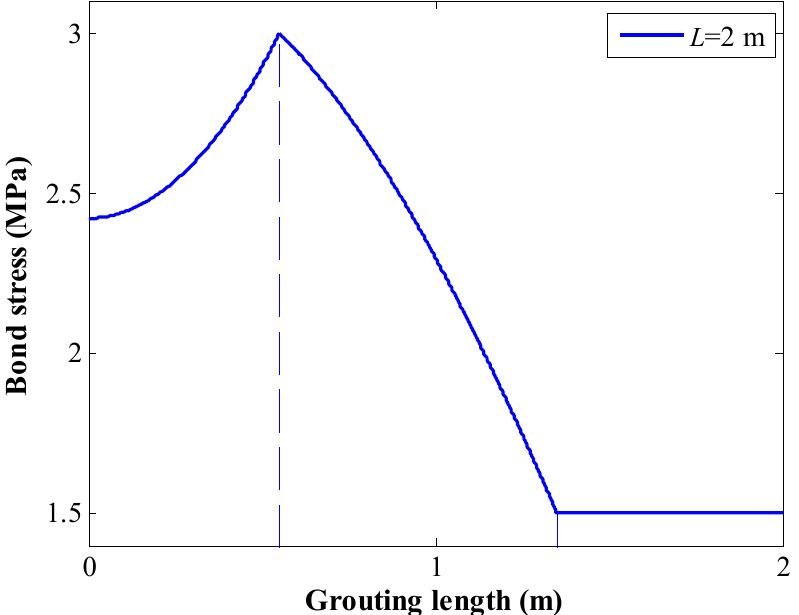
Figure 10. Reverse-calculating the ideal grouting length of the bars.